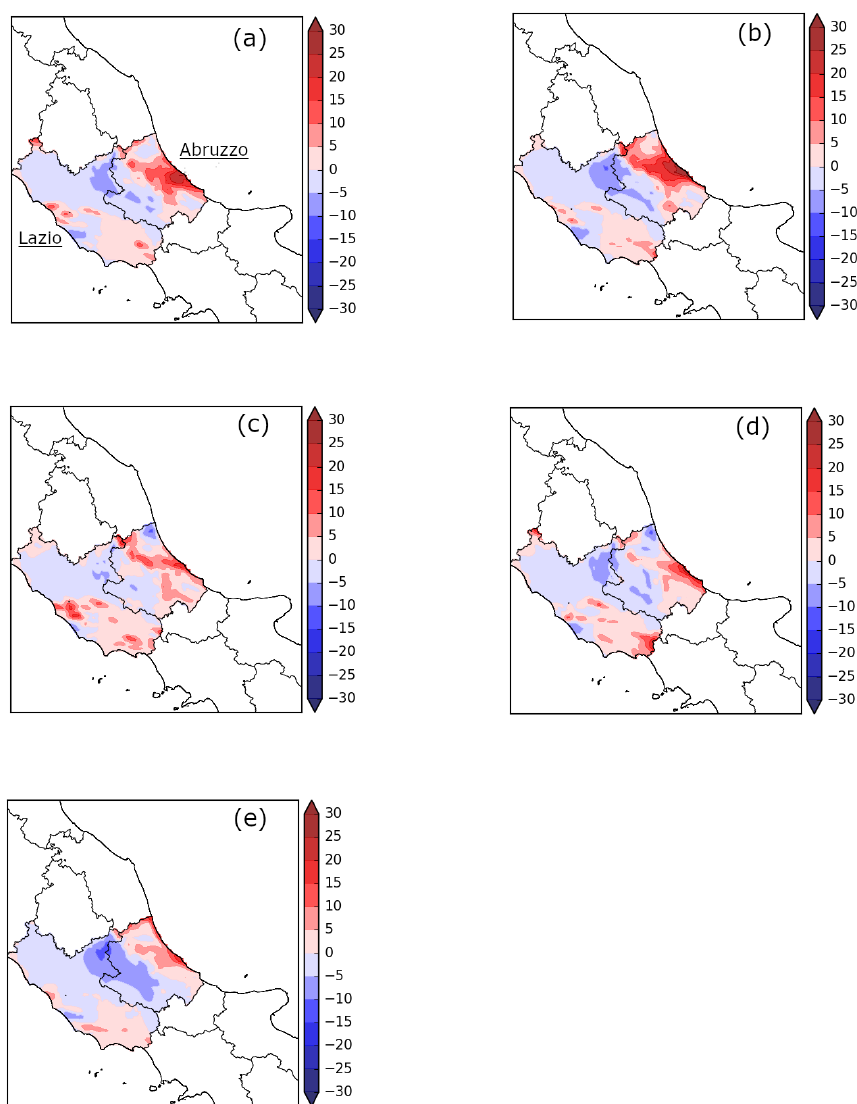
Figure 6. Differences (mm) between observed and predicted 3-hourly precipitation fields for the CYC4DVAR_cold (a) , CYC3DVAR_cold (b) , CYC4DVAR_warm (c) , CYC3DVAR_warm (d) and CTL (e) simulations in the Lazio Abruzzo